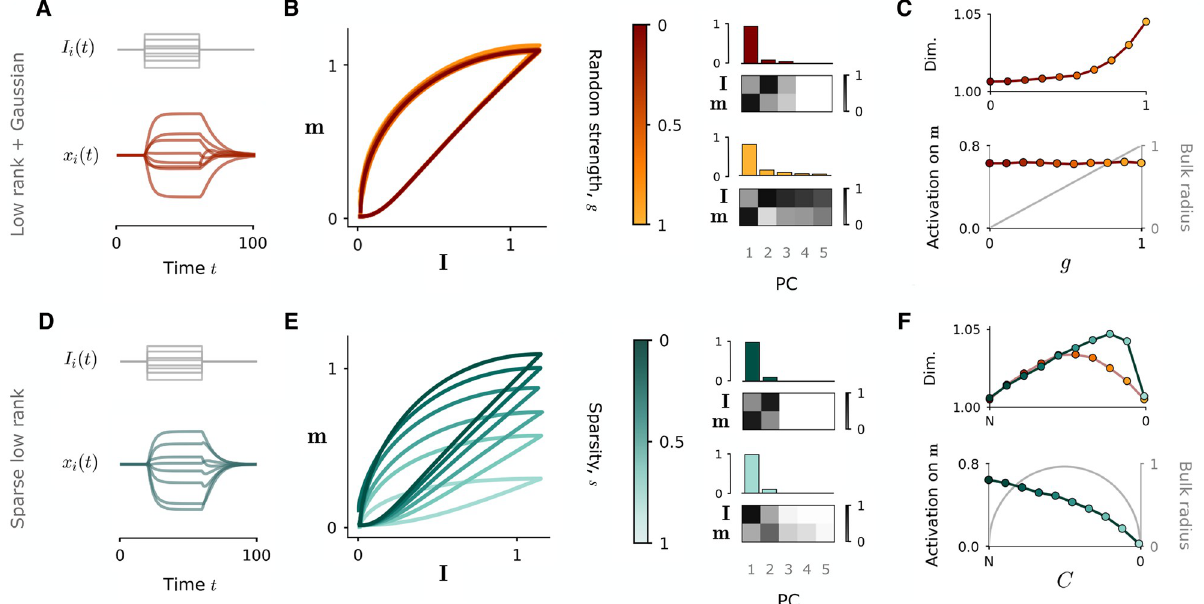
Fig 4. Impact of sparsity on input-driven dynamics. Network responses to a step input current along a random vector I . A-C : network consists of a dense rank-one component 1 and a full-rank, Gaussian component of variance g 2 / N ; the random strength g is progressively increased from zero to m n i j N one, in order to increase the radius of the eigenvalue disk from zero to one. D-F : network consists only of rank-one component P ij = m i n j ; the sparsity is progressively increased by decreasing the number of non-zero connections C . Parameters are chosen such that the radius of the eigenvalue bulk also spans the range [0, 1) as sparsity is modulated ( σ 2 = 0.043). The outlier is fixed at zero ( σ mn = 0). The input vector I partially overlaps with n ( σ nI = 0.2). A, D : Temporal dynamics of the network during step input ( A : g = 0.8; D : s = 0.8). Top: samples of input timeseries u ( t ) I i . Bottom: samples of network activations x ( t ). B, E : Left: input-driven population trajectories projected onto the plane defined by the right connectivity vector m and input vector I , i as random strength (resp. sparsity) is progressively increased. Right: principal component analysis (PCA) of each trajectory, showing the fraction of variance explained by the first three components (upper panels) and the correlation between first three principal components and the vectors I and m (lower panels). Examples are shown for both low and high random strength (resp. sparsity). C, F : Top: Dimensionality of network trajectories P P quantified by the participation ratio ð l Þ 2 = ð l 2 Þ , where λ i are the eigenvalues of the covariance matrix of activations. Bottom: Projection of i i i i ). The analytical radius of the corresponding eigenvalue disk is also network activation x onto the right connectivity vector m (the latent variable κ r shown in grey. For comparison, we also plot the dimensionality of Gaussian network trajectories corresponding to values of g equal to the radius of the sparse networks (red curve). The mean value for both dimensionality and projections is taken over 50 simulations for each value of g and C . Parameters for all graphs: N = 2000, σ 2 = 0.043, σ mn =